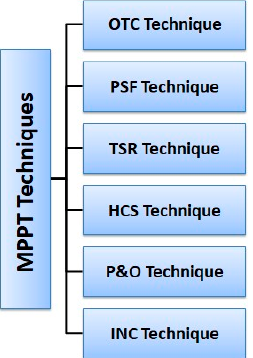
Figure 8. Classification of MPPT Techniques.